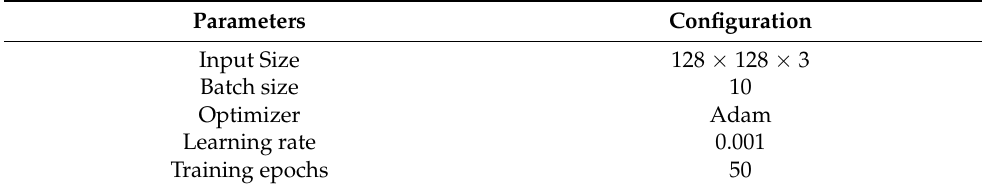
Table 2. Experimental